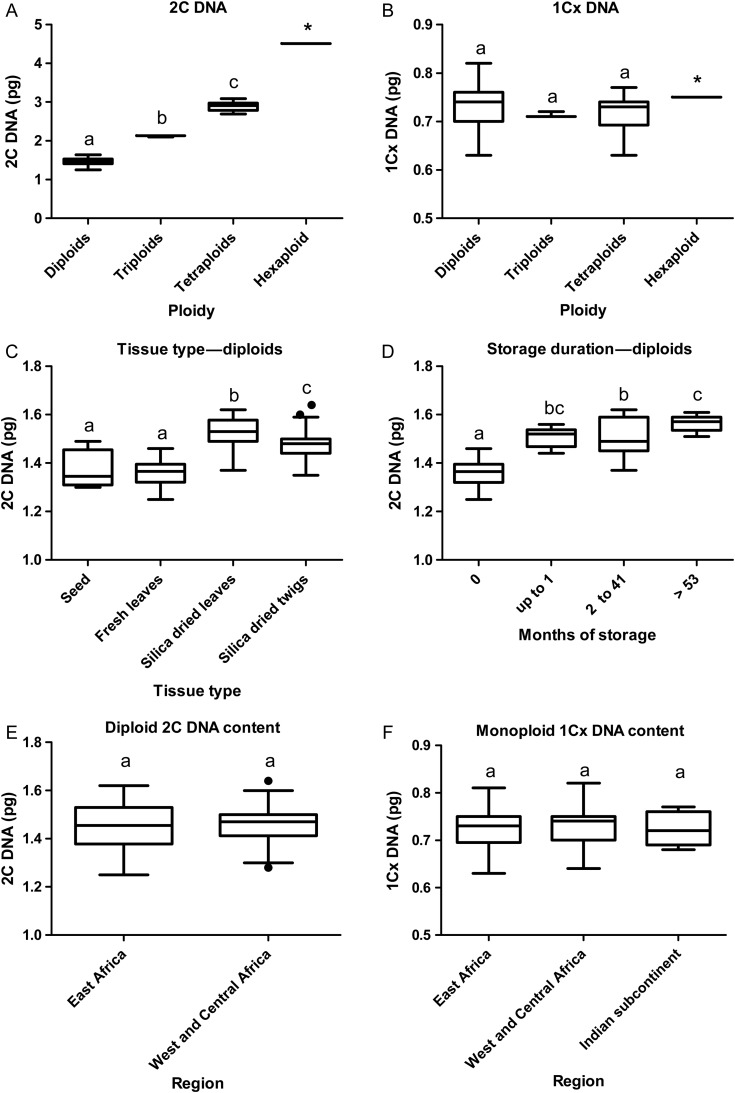
Box-plot representations of A. senegal (A) 2C DNA, (B) monoploid (1Cx) values comparing ploidy levels; (C) 2C DNA comparing tissue types of diploid individuals, (D) 2C DNA values comparing storage duration; (E) 2C DNA of diploid individuals and (F) monoploid (1Cx) values of all ploidy levels comparing biogeographical regions. Means not significantly different at P < 0.05 are indicated by the same letter (Tukey's post test, or two-tailed unpaired t-test). Horizontal lines represent the median, and boxes and whiskers, respectively, the interquartile range and the non-outlier ranges. Circles denote outliers. An asterisk (*) indicates the single hexaploid DNA content value (4.51 pg) is not included in the ANOVA analysis.